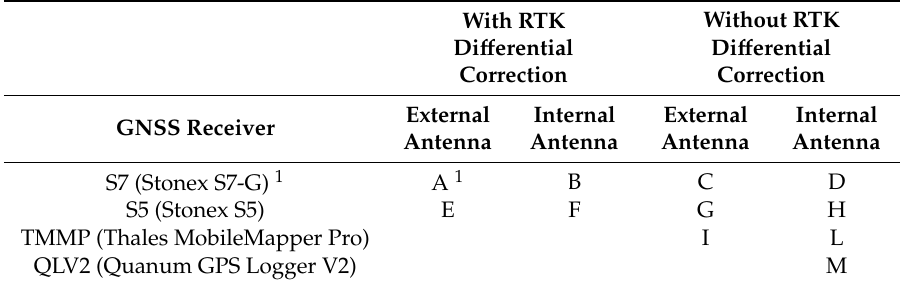
Table 1. Tests carried out by using the four satellite receivers with and without RTK differential correction and with and without external antenna.